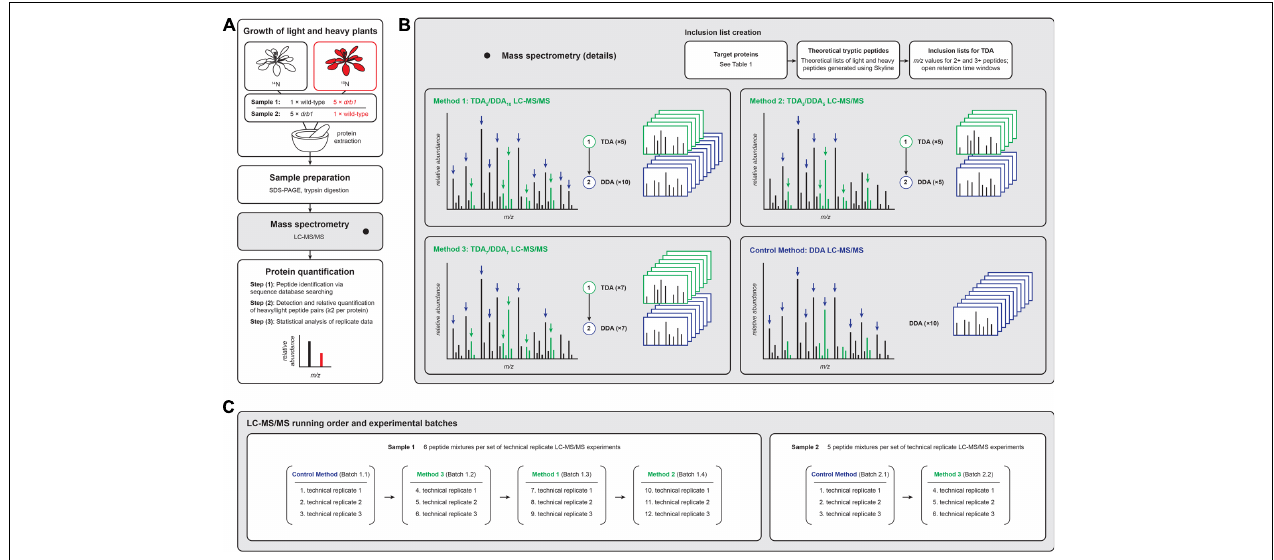
FIGURE 1 | Experimental workflows for the LC-MS/MS-based relative quantification of plant proteins used in the present investigation. (A) Proteins from unlabeled ‘light’ and 15 N-labeled ‘heavy’ plants were mixed, jointly prepared for LC-MS/MS analysis, and the data analyzed following established procedures [see Ting et al. (2009) and Reis et al. (2015a) for detailed descriptions of the statistical procedures required to quantify proteins using these data]. (B) TDA/DDA LC-MS/MS methods employed TDA inclusion lists for the hypothesis driven selection of peptides for MS/MS, followed by DDA for non-hypothesis driven data collection; the LC-MS/MS control method employed DDA only. Green MS signals represent peptides derived from targeted proteins, and black MS signals represent other peptides. Heavy peptides (colored red in A ) are not differentially colored in B . (C) Batches of LC-MS/MS experiments were performed, with each batch comprised of three sets of technical replicate TDA/DDA or DDA experiments. Proteolytic peptide mixtures derived from sample 1 were analyzed using all TDA/DDA and DDA methods; proteolytic peptide mixtures derived from sample 2 were analyzed using TDA 7 /DDA 7 (method 3) and the DDA control method